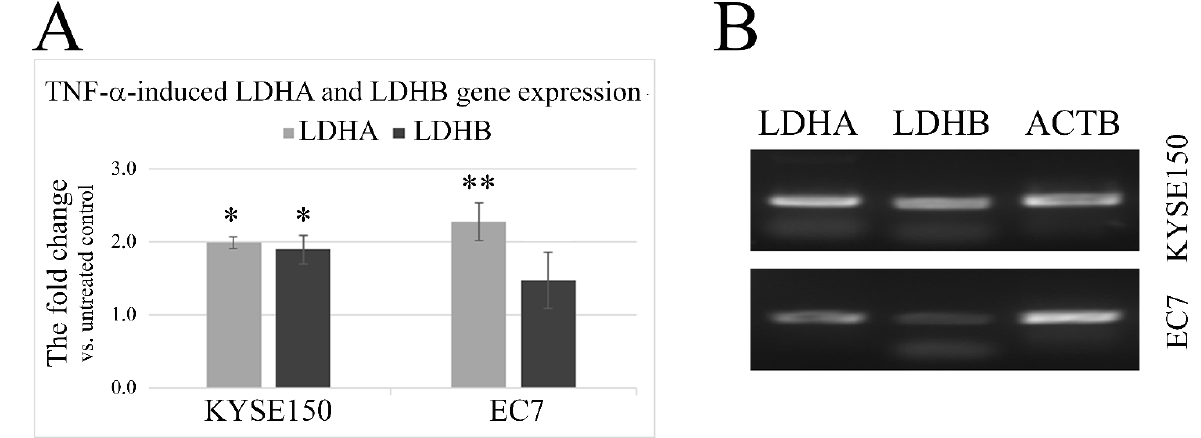
Figure 2. Expression levels of LDHA and LDHB in esophageal cancer cells. ( A ) RT-qPCR analysis of LDHA and LDHB expression changes in response to TNF- α (30 ng/mL) stimulation for 24 h in ESCC and EAC cells (KYSE150 and EC7, respectively). Statistically significant increase in TNF- α -dependent expression for both LDHA (FC = 1.98 ± 0.08 vs. untreated control) and LDHB (FC = 1.88 ± 0.2 vs. untreated control) was found in KYSE150 cells. In the presence of TNF- α in EC7 cells, only LDHA levels significantly increased (FC = 2.28 ± 0.26 vs. untreated control). ( B ) LDHA and LDHB mRNA expression in two esophageal cancer cell lines, KYSE150 and EC7, by regular RT-PCR. ACTB ( β -actin) was used as an internal control. * p < 0.05, ** p < 0.001.